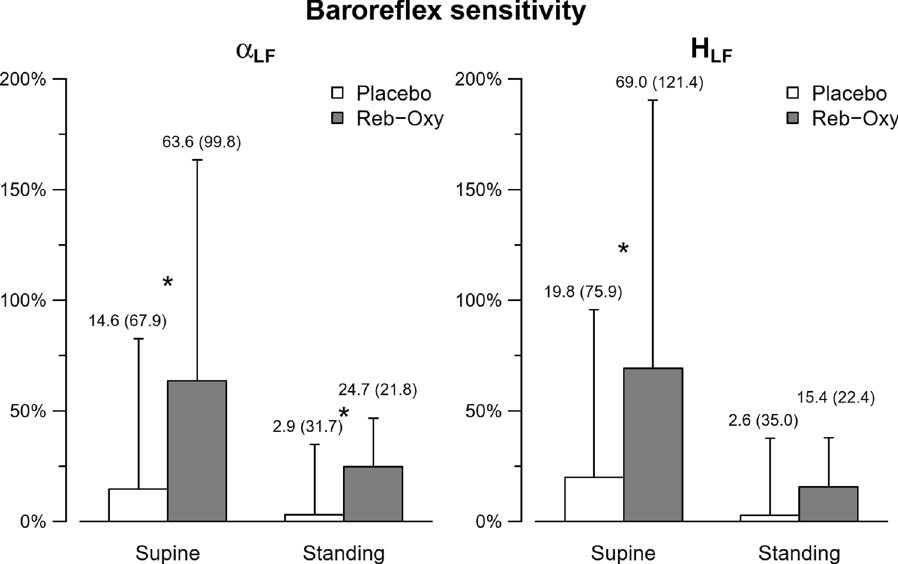
Figure 1. Baroreflex sensitivity by the spectral method. αLF percent change (left) and HLF percent change (right) from baseline under placebo (white bar) and reb-oxy (grey bar) in supine and standing positions. Data are shown as medians (median absolute deviation); the * indicates statistical significance between reb-oxy and placebo. See Table 4 for the original values.